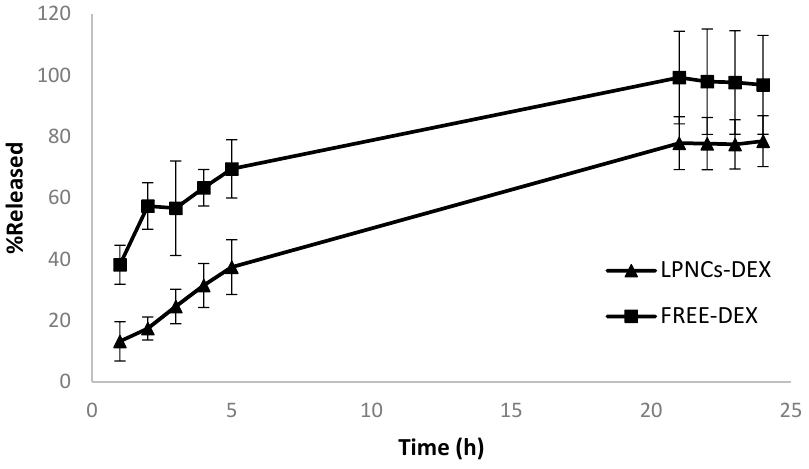
Figure 4. Mean release data obtained from the DEX-loaded LPNCs and from the ethanolic solution of DEX (FREE-DEX) after 24 h of the in vitro release test.